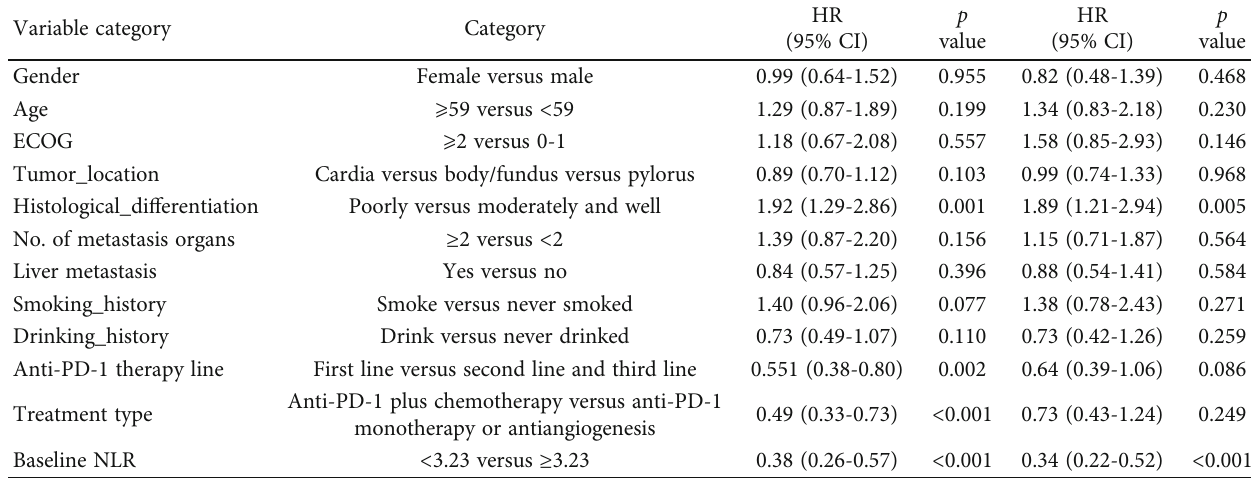
Table 4: Univariate analysis and multivariate analysis of overall survival